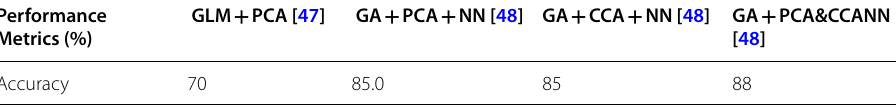
Table 3 Comparative of the performance metrics with the State-of-the-art Performance Metrics